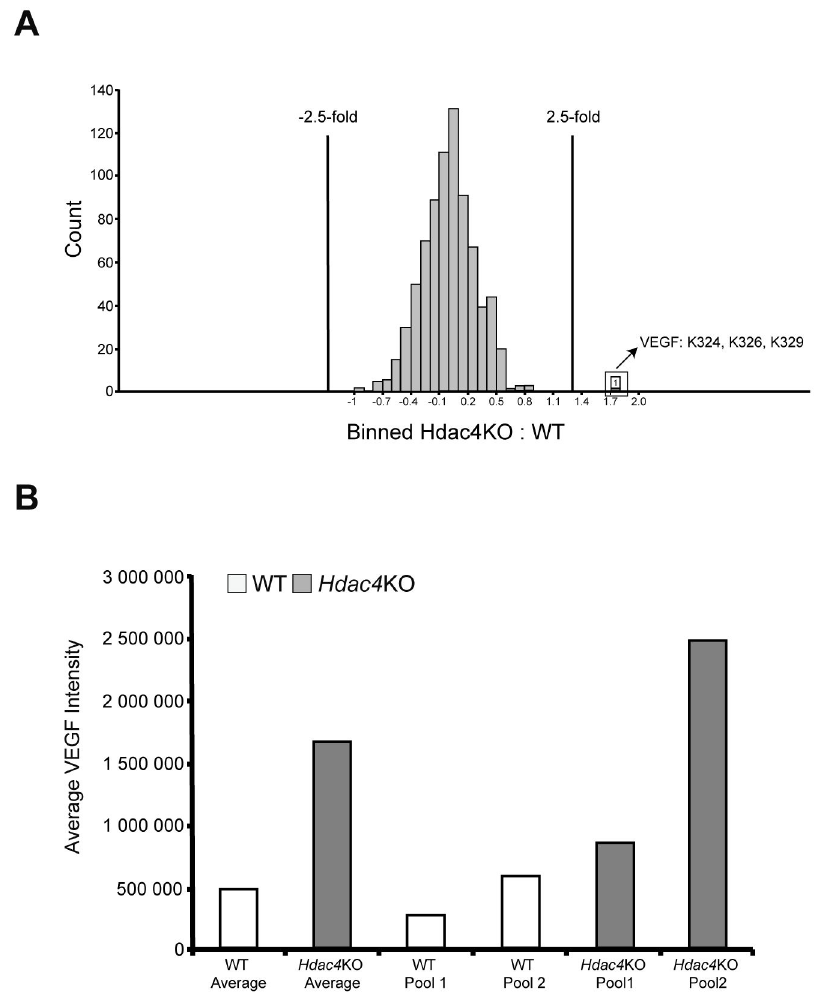
Figure 1. Absence of HDAC4 causes only minor changes to the neonate brain acetylome. (A) Histogram showing normalized log ratios between HDAC4 KO and WT brains for all peptides identified. The VEGF peptide with a >2.5-fold change is highlighted. 2 (B) Relative abundance for VEGF K324, 326, 329 acetylated peptide across all samples (control and HDAC4 KO pool1 and pool 2).